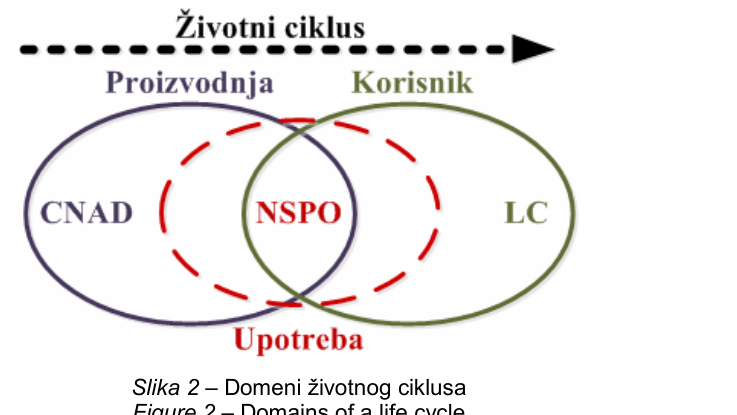
Рис . 2 – Этапы жизненного